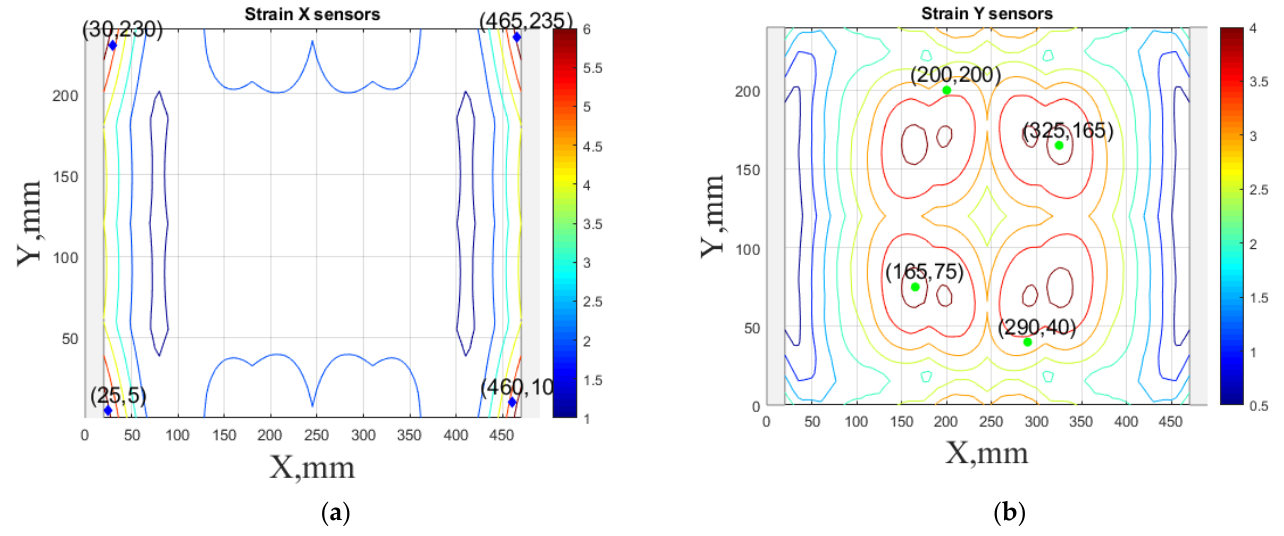
Figure 6. The sensor networks obtained using the A2 method with four sensors in each direction: the sensor network in X ( a ) and Y directions ( b ). Shaded regions represent the mounting clamps.